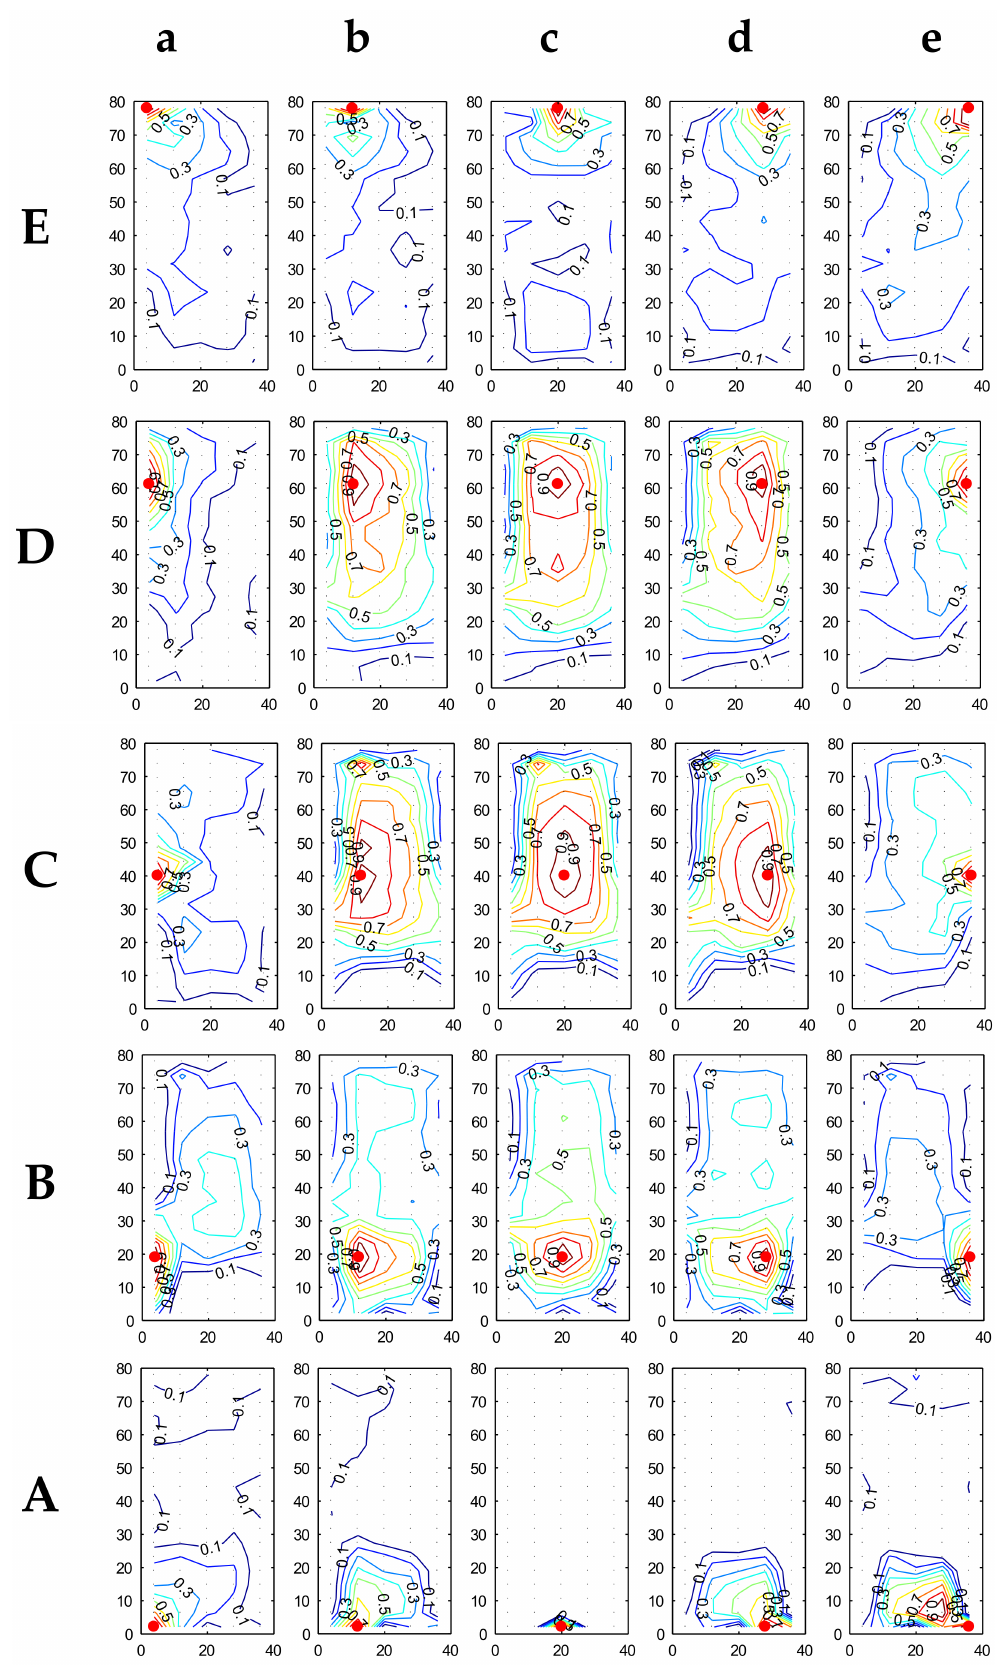
Figure 5. Correlation coefficient trend for RLC at 0 ◦ . Color bar as in Figure